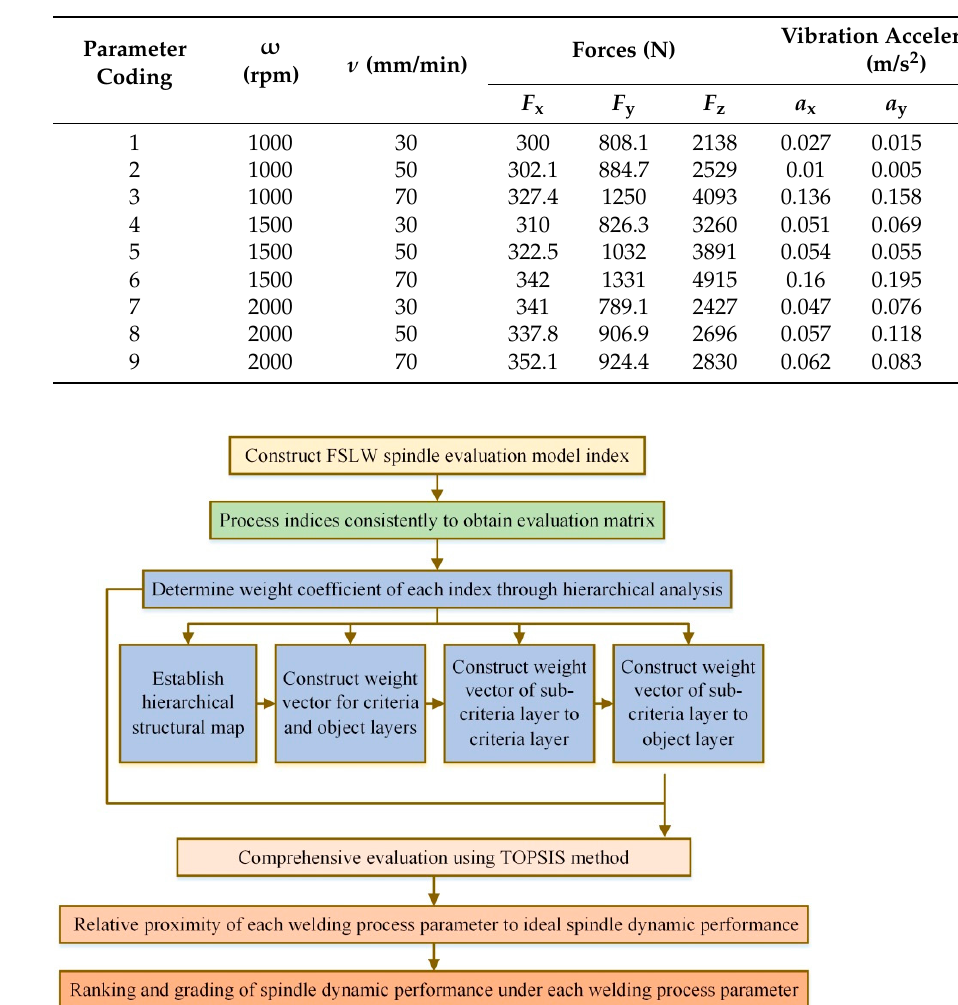
Figure 2. Spindle dynamic performance evaluation model using the Technique for Order Preference by Similarity to the Ideal Solution (TOPSIS). Table 2. Dynamic performance of spindle under different welding parameters.